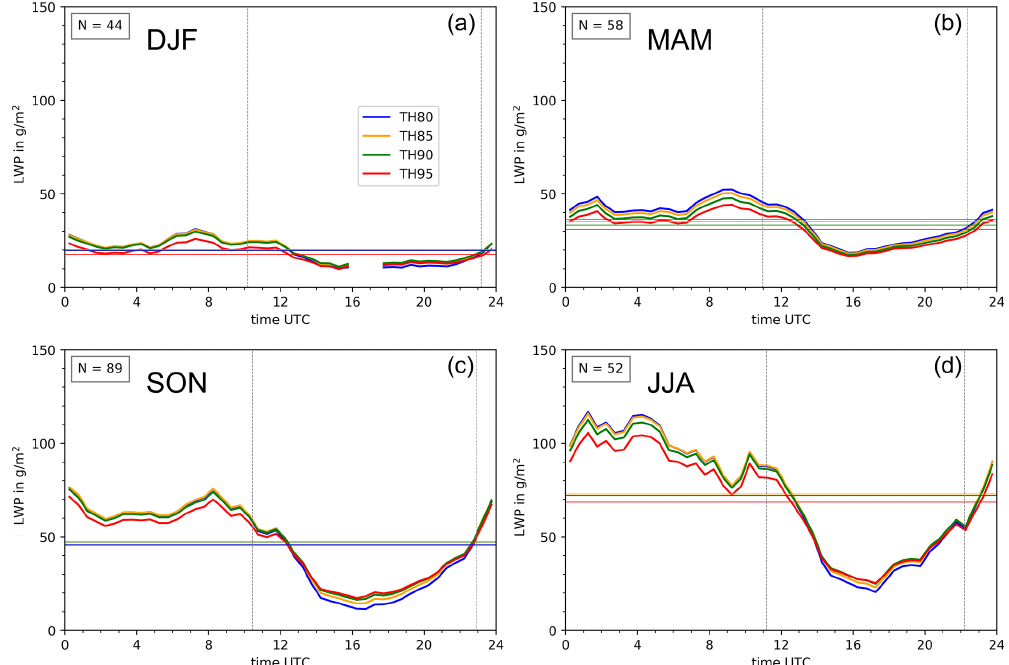
Figure 8. Average diurnal course of the liquid water path (LWP) during different seasons. Clockwise: (a) austral summer (DJF), (b) fall (MAM), (d) winter (JJA) and (c) spring (SON). Different colors depict different LWP retrievals (see Sect. 2.2.2). Horizontal lines indicate seasonal averages. The value of N gives the number of days analyzed. Vertical dashed lines indicate the average times of sunrise and sunset. The gap around 17:00UTC in austral summer (DJF) is due to times when the Sun is in zenith, making retrieval